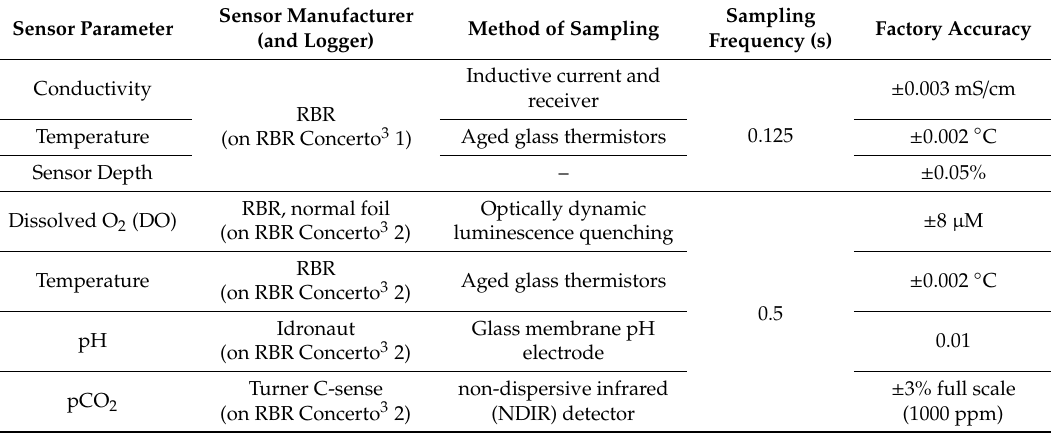
Table 1. Sensors mounted on CW4. There are two RBR Concerto 3 loggers mounted on the CW4, with di ff erent sensors attached, di ff erentiated by numbers in